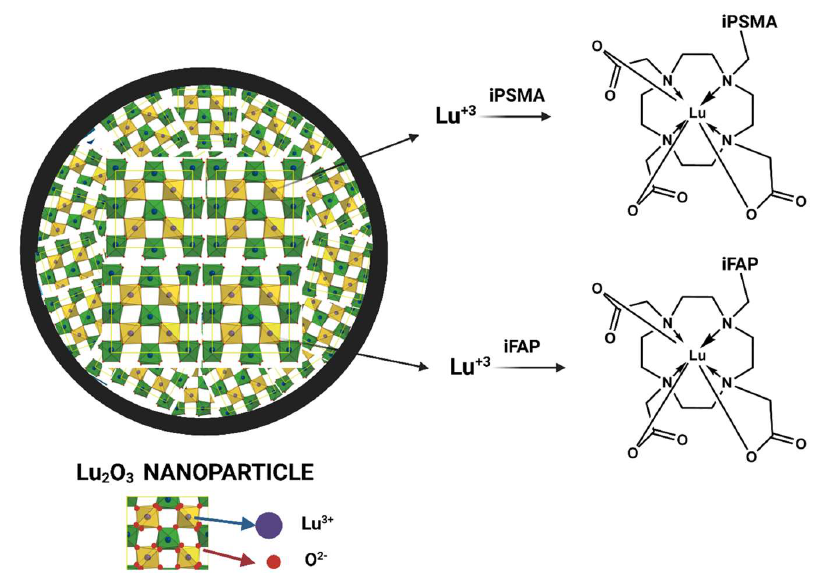
Figure A3. Schematic structure of the Lu − DOTA − iPSMA/iFAP complexes produced on the surface of lutetium sesquioxide nanoparticles